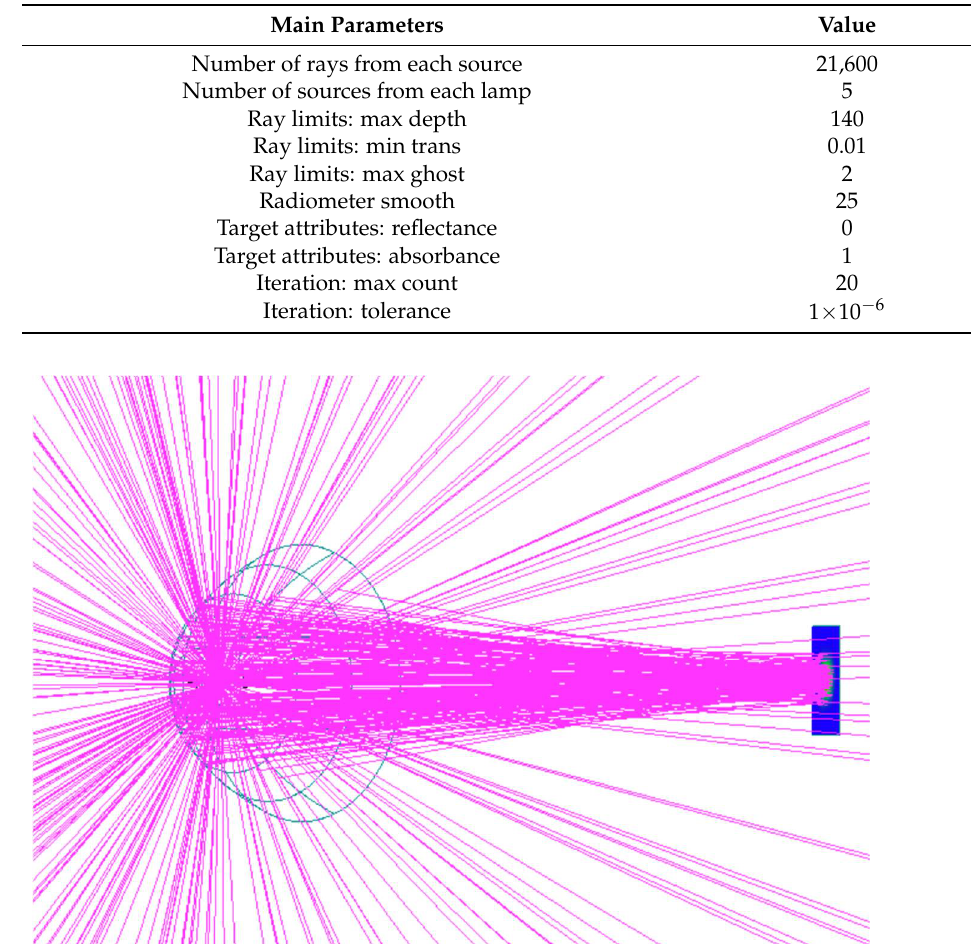
Figure 8. Radiative flux map in W/cm 2 calculated at the focal plane, related to the lamp n. 7; the coordinates are expressed in cm from the center of the workbench.